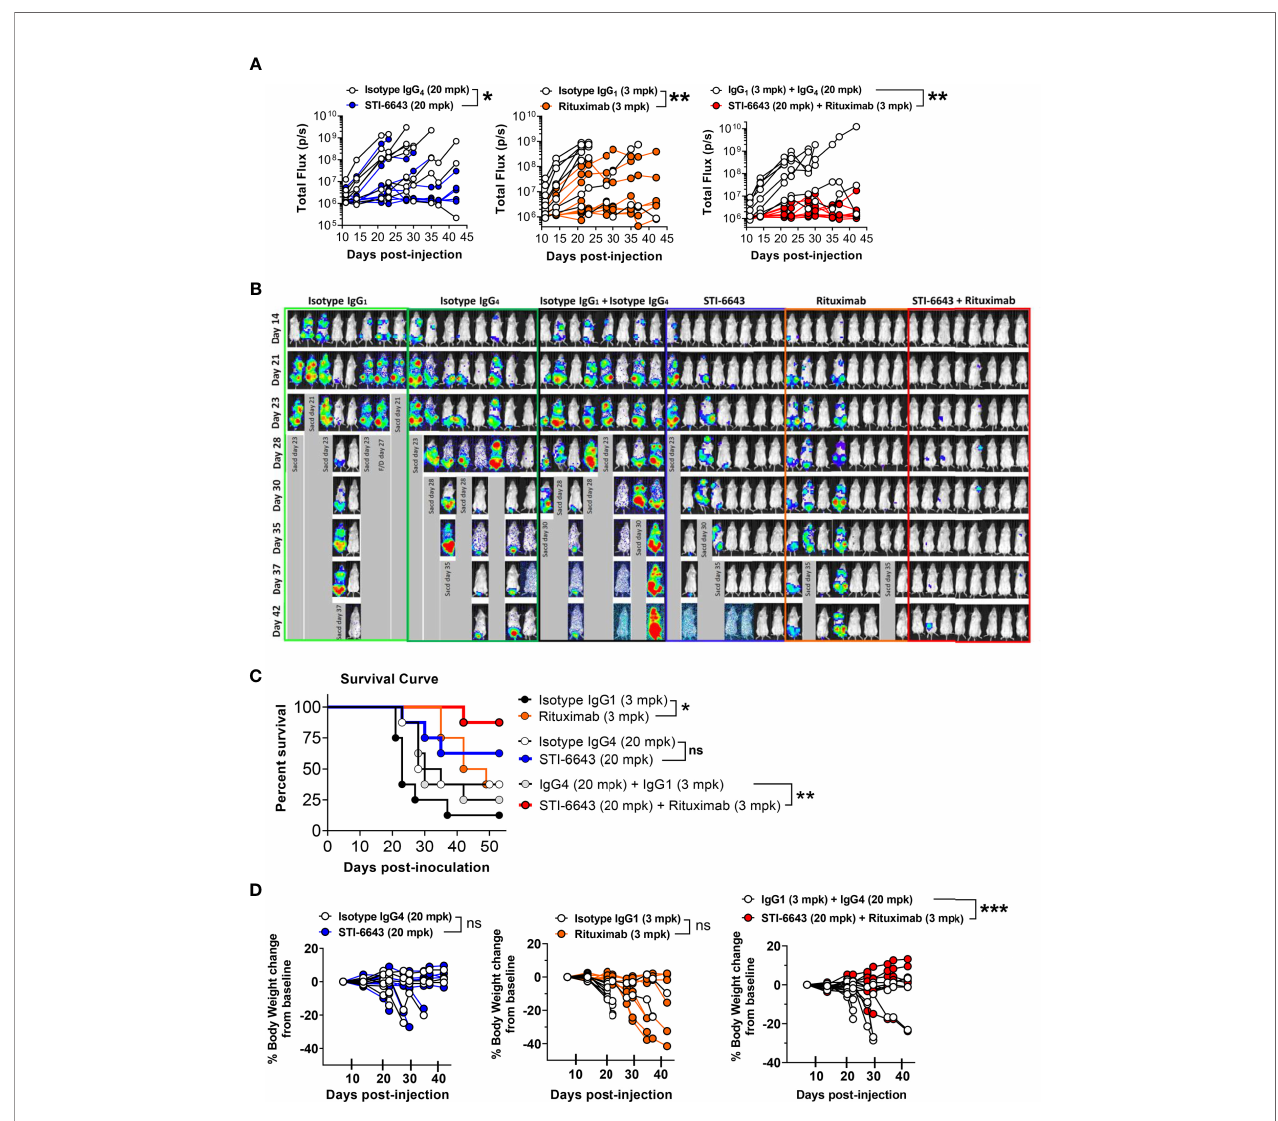
FIGURE 6 | Addition of STI-6643 to Rituximab therapy foster anti-tumor activity in a Burkitt ’ s lymphoma xenograft model. (A) Systemic tumor burden measured by whole body bioluminescence (total fl ux) of individual mice in mice treated with STI-6643 and rituximab alone or in combination. Statistical analysis was conducted by comparing data from the anti-CD47 and Rituximab mono or combo-treatment groups to the isotype IgG 4 treated groups. (B) Images of whole-body luminescence recorded from individual mice. (C) Survival data displayed for each treatment group. (D) Percent body weight change from baseline for each group until study termination of the study. Data are representative of two independent experiments. Group size is 8 animals per treatment condition. Statistical signi fi cance assessed by two-way ANOVA (B) and log-rank Mantel-cox test (C) ; (not signi fi cant [ns], p>0.05; *p ≤ 0.05; **p ≤ 0.01; ***p ≤